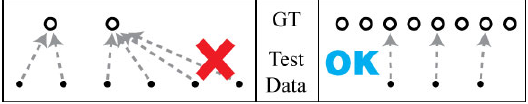
Figure 5. Point density and coverage